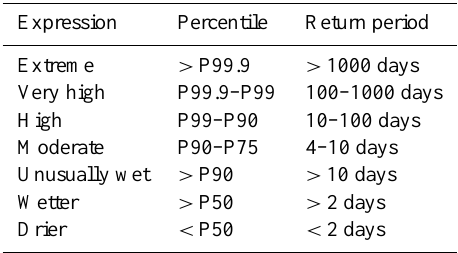
Table 2. Expressions used to define different quantities of precipi-